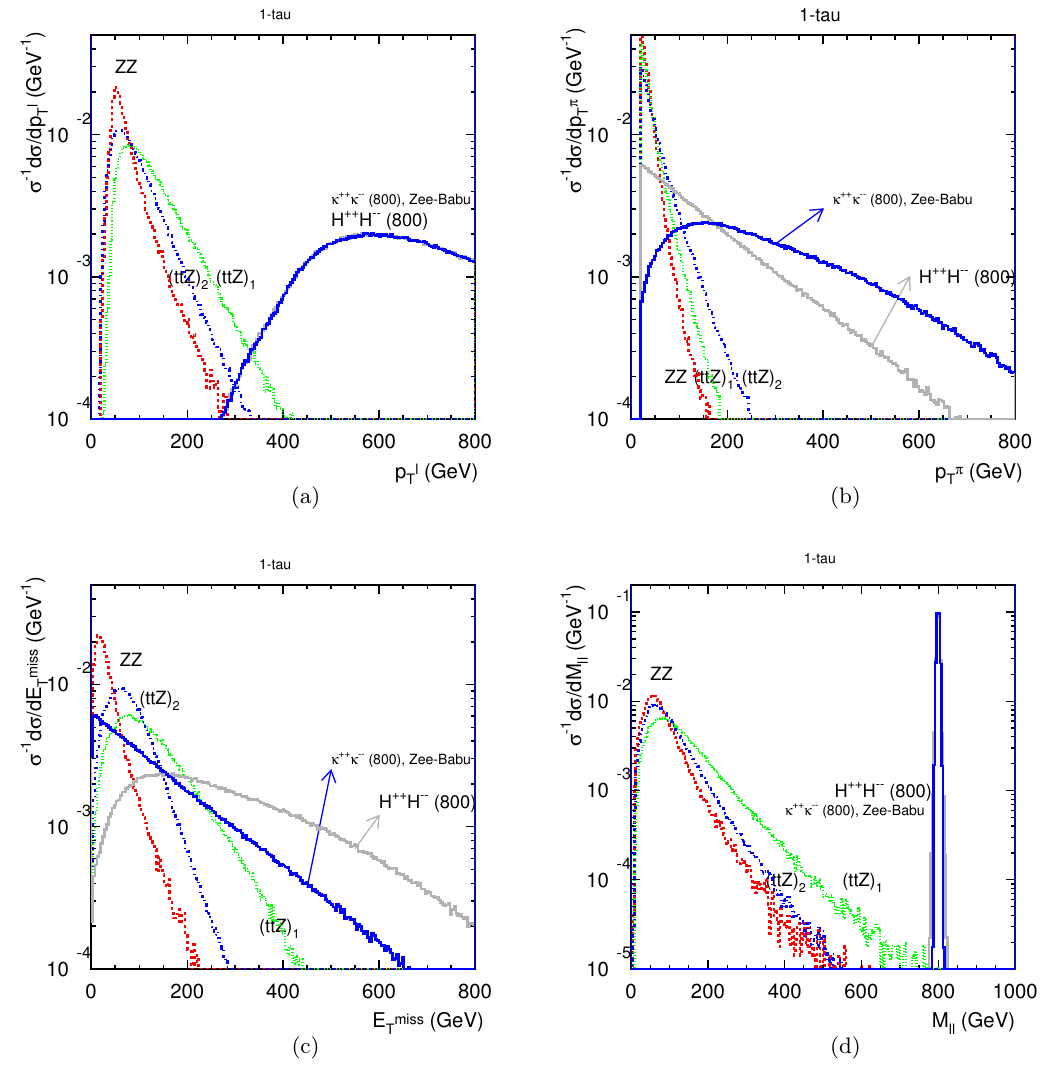
Figure 3 . The normalized di(cid:11)erential cross section distributions of signal pp ! H ++ H (cid:0)(cid:0) ! ( (cid:0) ) (cid:28) (cid:6) ‘ (cid:6) ‘ (cid:7) ‘ (cid:7) with (cid:28) (cid:6) ! (cid:25) (cid:6) (cid:23) (cid:28) and backgrounds versus (a) p max